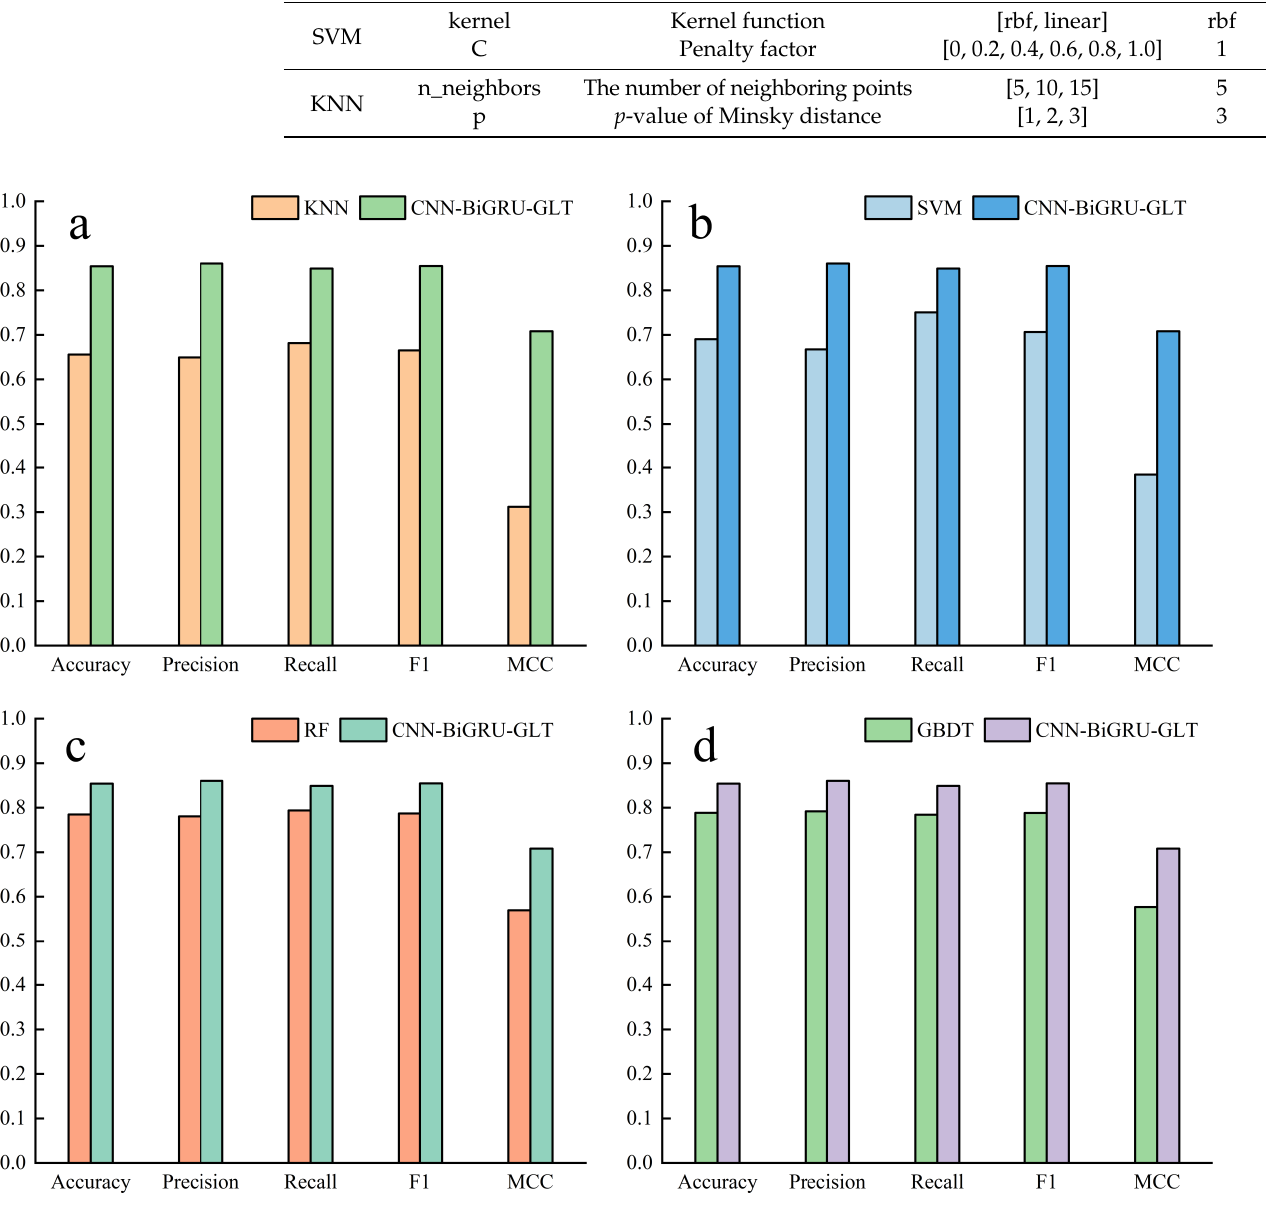
Figure 5. Comparison of the CNN-BiGRU-GLT model with traditional machine learning methods on validation set: ( a ) CNN-BiGRU-GLT and KNN performance comparison; ( b ) CNN-BiGRU-GLT and SVM performance comparison; ( c ) CNN-BiGRU-GLT and RF performance comparison; ( d ) CNN-BiGRU-GLT and GBDT performance comparison. Table 7. Specific metric values of the CNN-BiGRU-GLT model compared to traditional machine learning methods on the validation set.